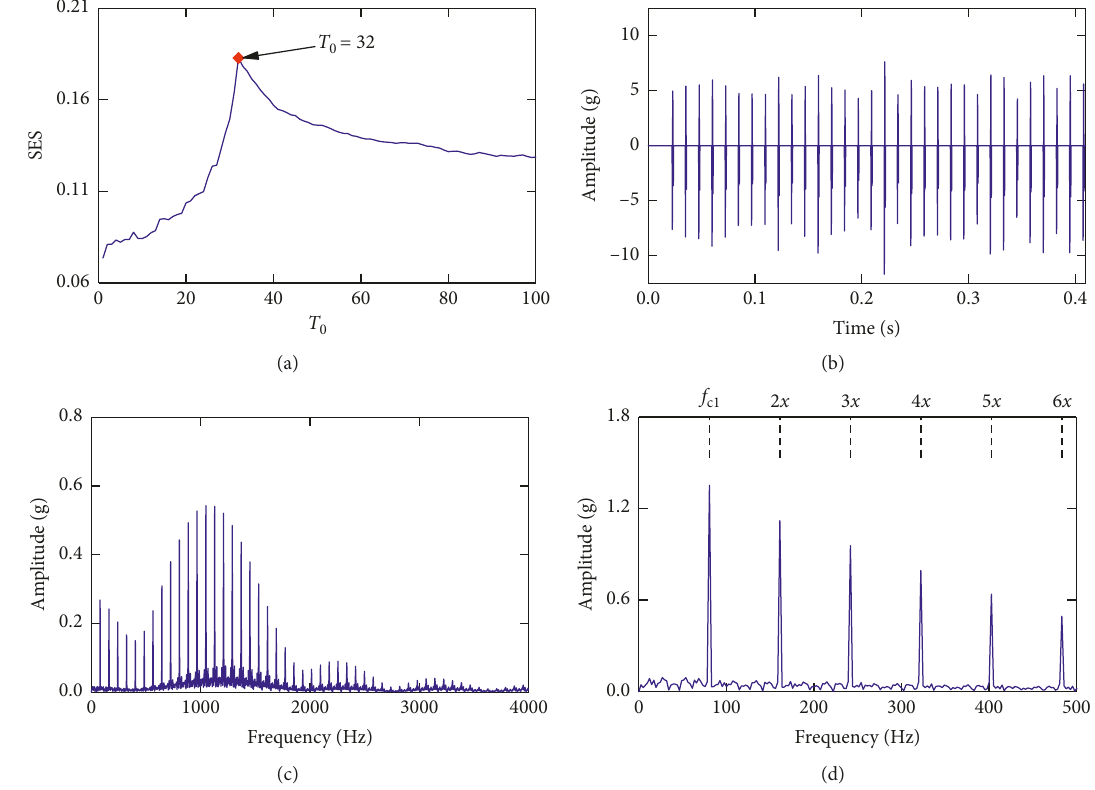
Figure 6: Separated first impulse signal 􏽢 y 1 using H-SI-K-SVD: (a) SES values for the different number of iterations; (b) time-domain waveform of 􏽢 y 1; (c) Fourier spectrum of (b); (d) Hilbert envelope spectrum of (c).